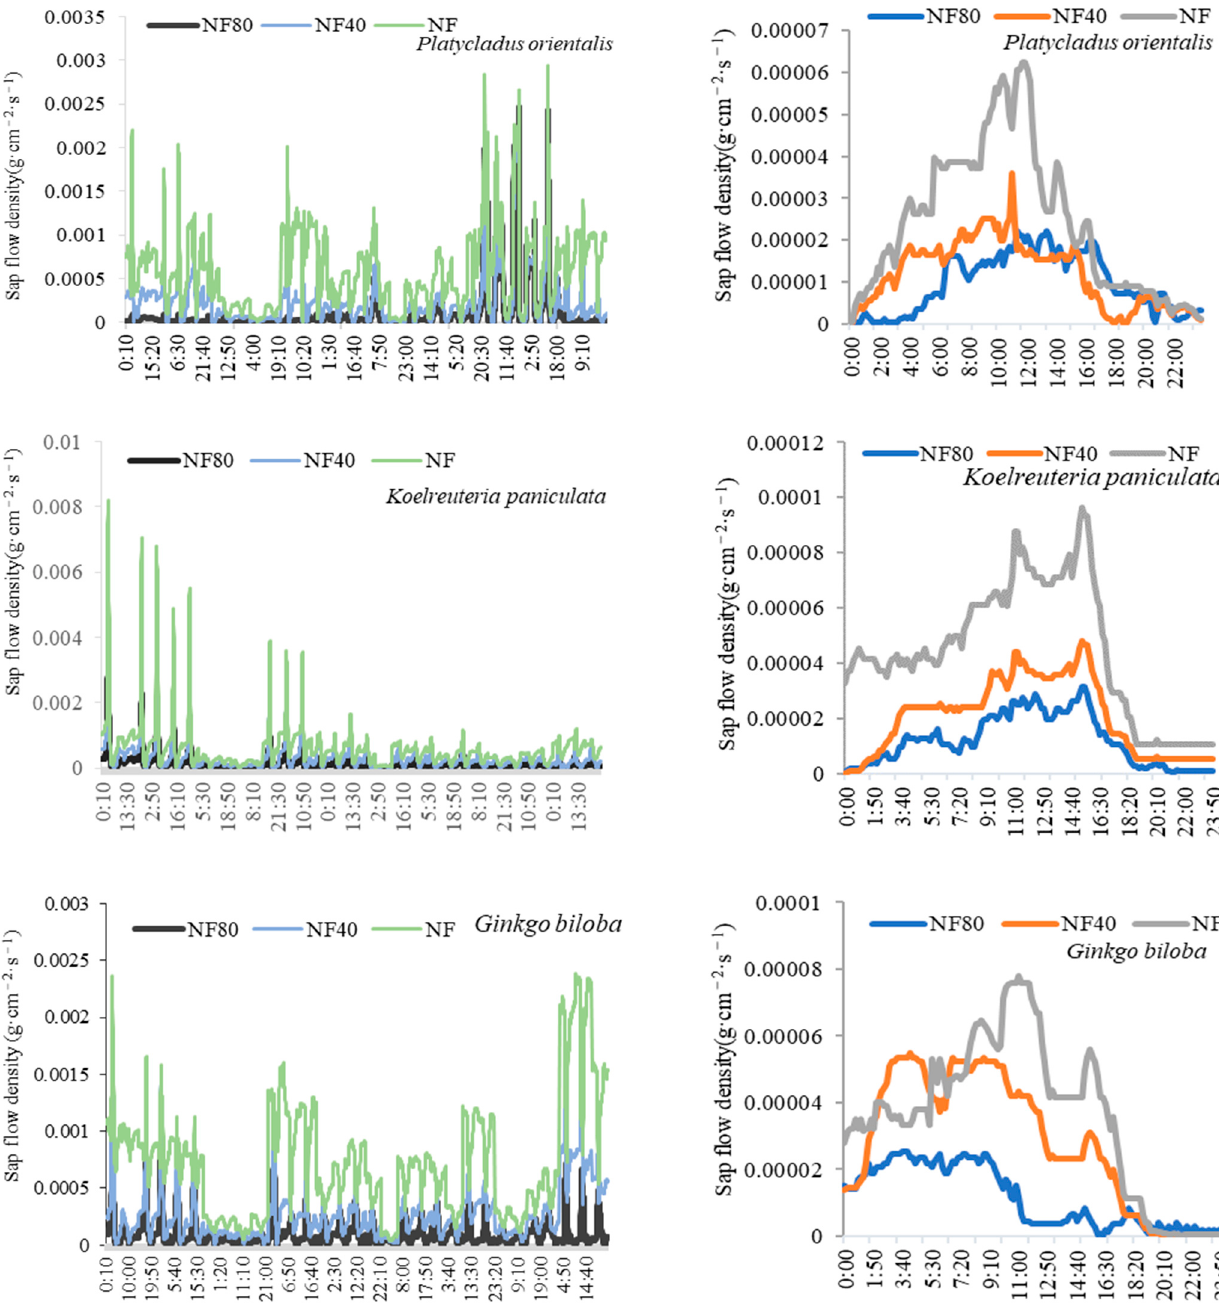
Figure 1. Monthly and daily variation of trees’ sap-flow density under different ozone concentrations.